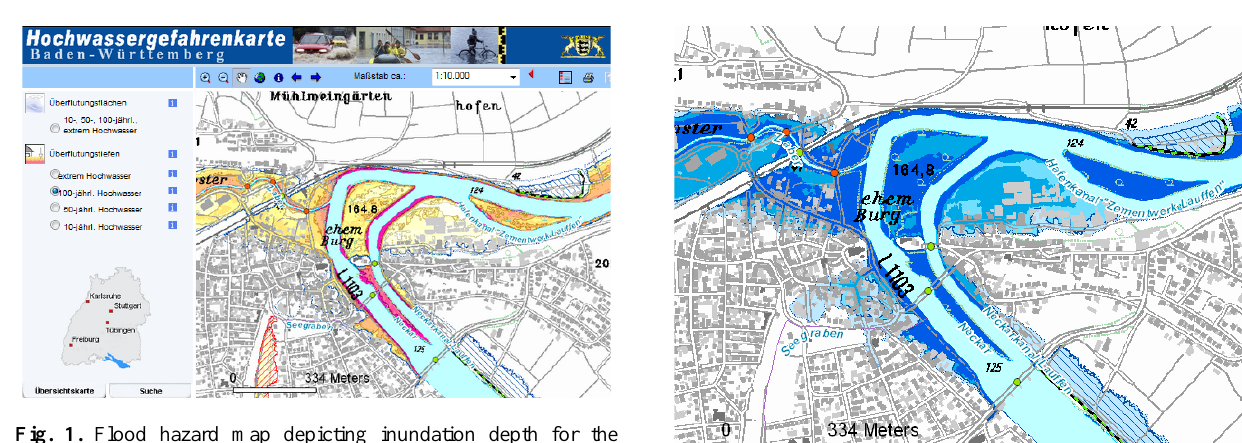
Fig. 1. Flood hazard map depicting inundation depth for the 1/100 years flood scenario. Screenshot from the online map service available from the Ministry of the Environment (http: //rips-dienste.lubw.baden-wuerttemberg.de/rips/hwgk internet/ %28S%28a3fxfb45rlyp0biu4xk2jj55%29%29/Default.aspx ).